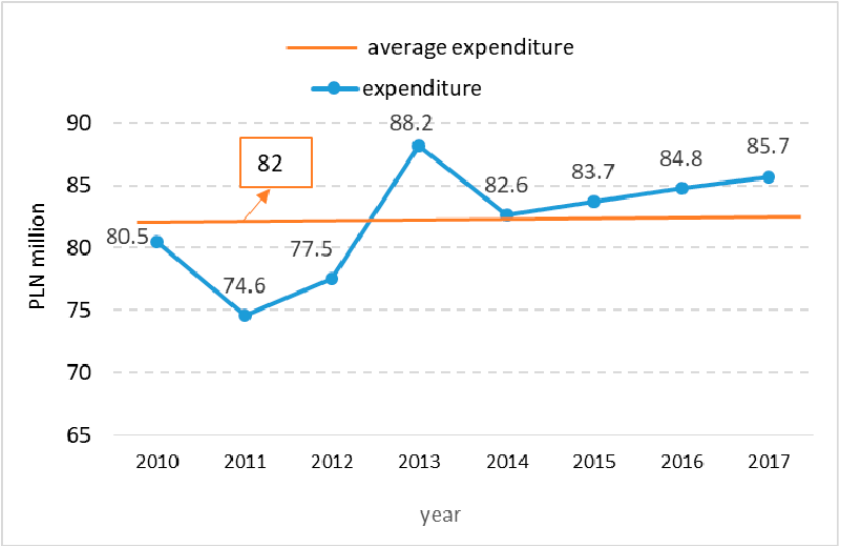
Figure 7. Expenditures on ICT, innovation and automatisation in the steel industry (manufacturers of basic metals) in Poland. Source: Data from GUS [122].